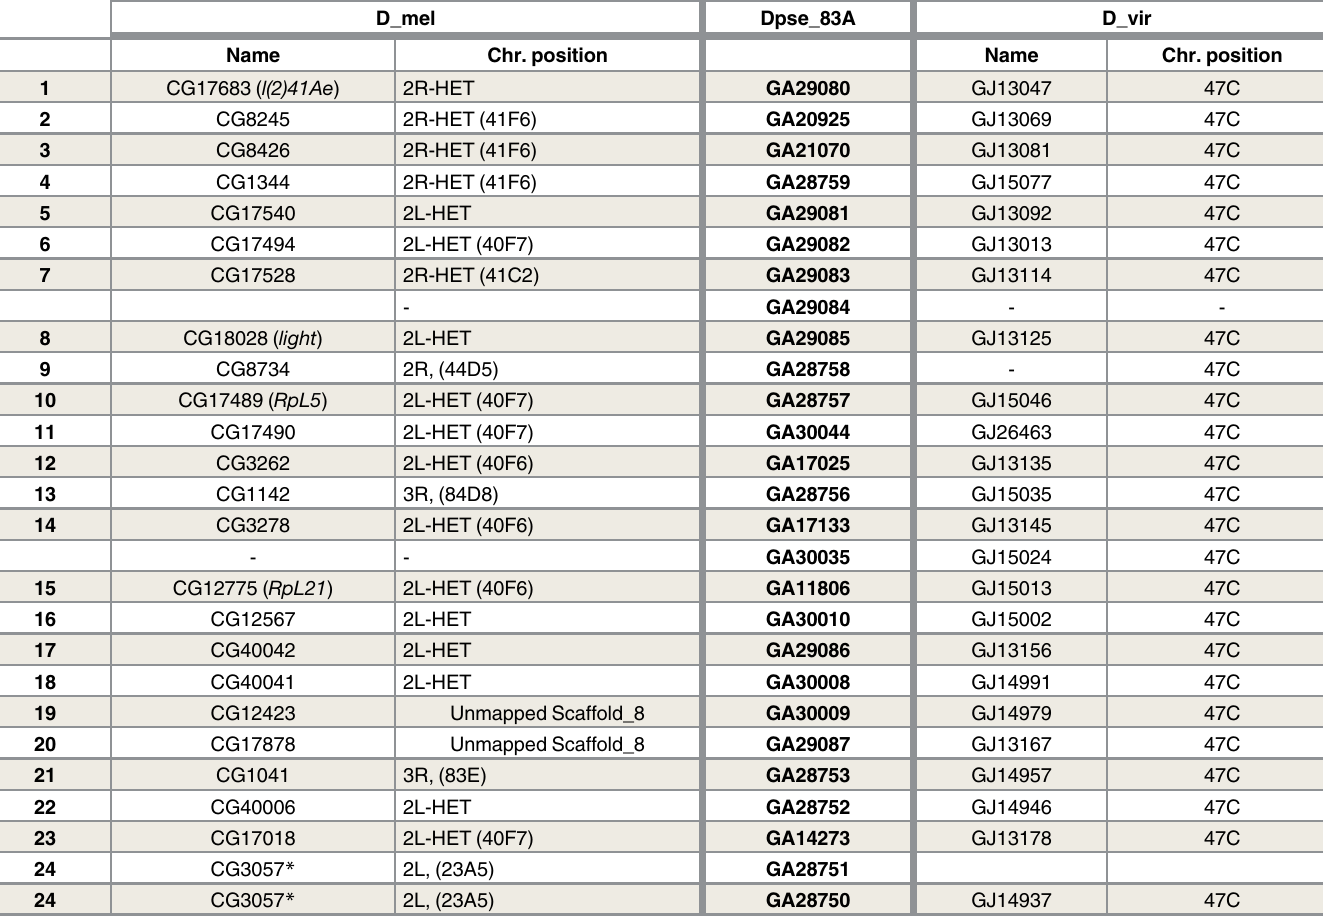
Both mitotic and polytene chromosome map of D . melanogaster heterochromatic genes are indicated. The gene marked by the asterisk is